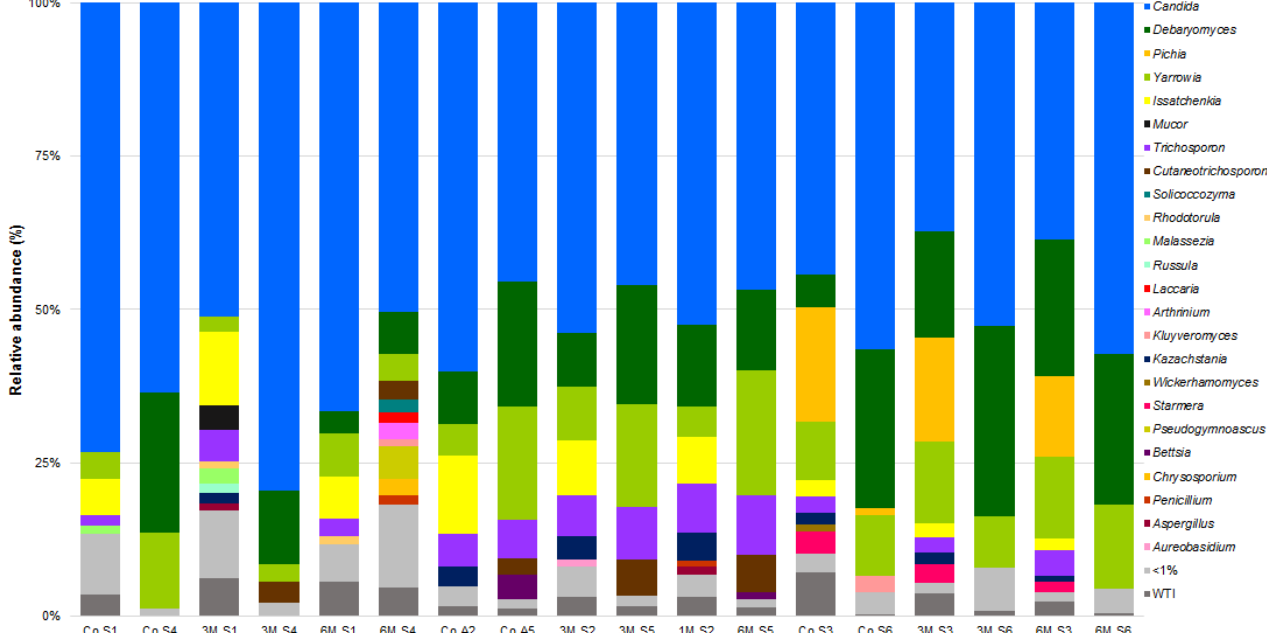
Figure 5. Relative abundances (%) of dominant sequences (>1%) assigned to genus level identified in Serra da Estrela cheese DNA samples based on partial sequence analysis of the Internal Transcribed Spacer 2 region in the rRNA gene. Co refers to the commercially used cardoon by the cheese producer and 1 M, 3 M and 6 M refers to specific cardoon genotypes. WTI refers to the percentage of sequences without taxonomic attribution to the specified taxonomic level.